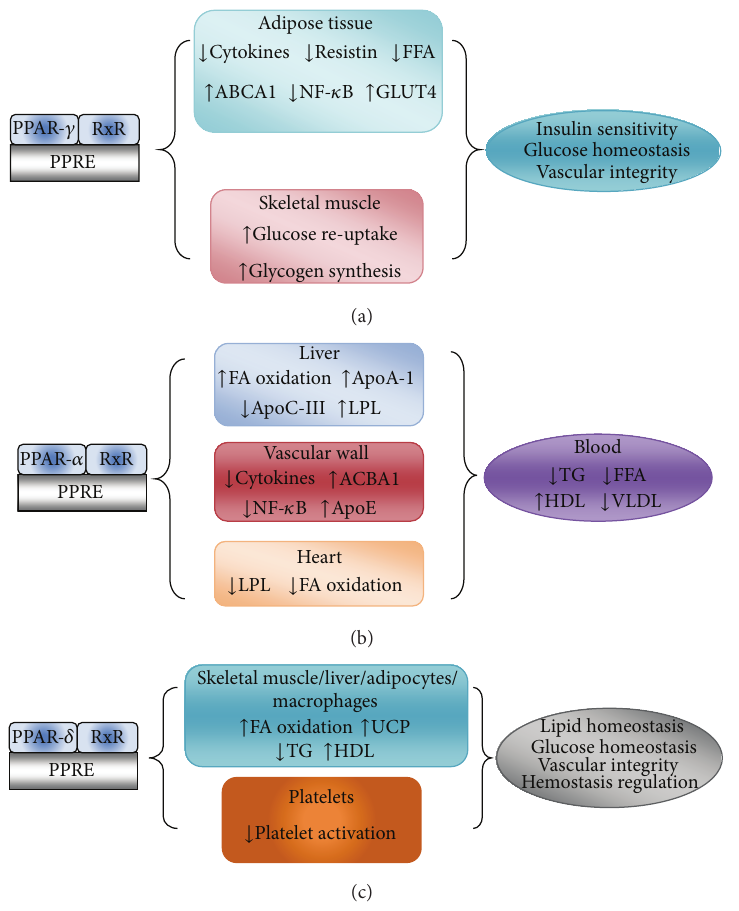
Figure 3: Mechanism of transcription and biological effects in different organs. (a) PPAR- 𝛾 exhibits anti-diabetic and atherosclerotic effects in adipocytes and skeletal muscle. (b) PPAR- 𝛼 has multiple effects on liver, heart, and vascular wall. (c) PPAR- 𝛿 is expressed widely throughout thebodyanditsgeneexpressionisinvolvedwiththemetabolismoflipidsandglucose,aswellasindecreasingtheplateletactivation.(Modified from